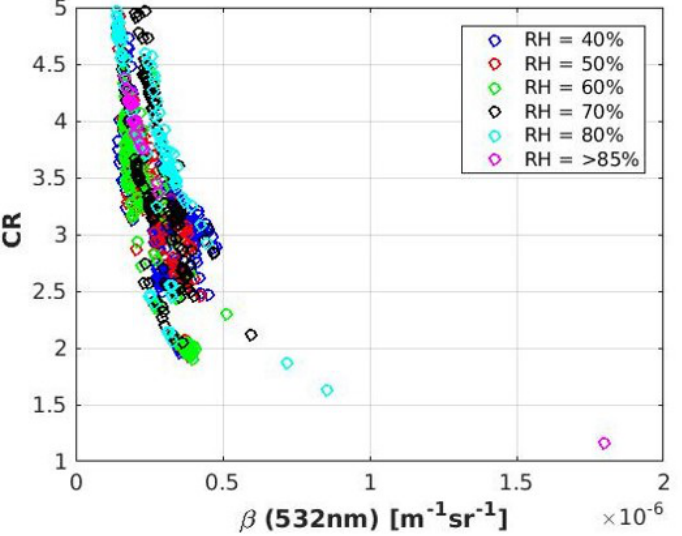
Figure 8. The colour ratio against the backscatter at 532 nm between 1500 and 2000 m altitude. The different colours indicate the corresponding RH